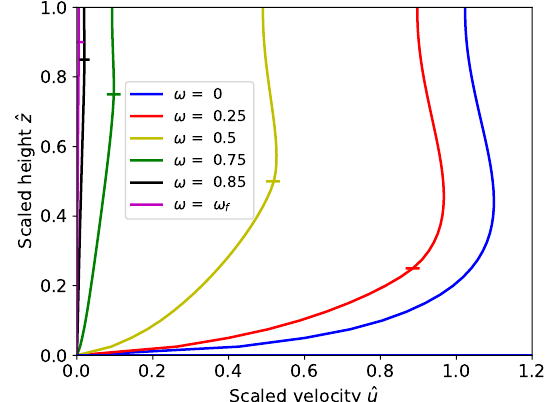
Figure 4. Scaled velocities along the vertical face of the calving front (solid lines) for different relative water levels. Horizontal line markers show the relative water level for each